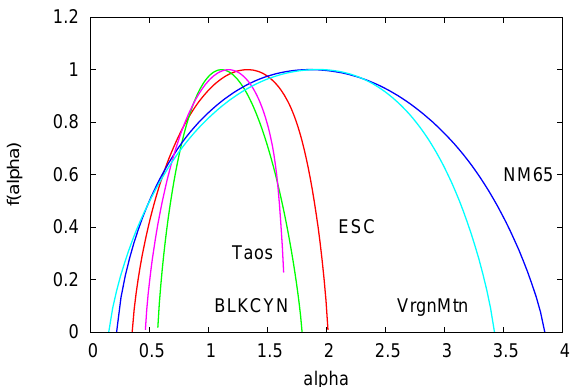
Fig. 7. Best-fitting model multifractal spectrum f ( α ) vs α for rock bodies of Precambrian age in southwest Colorado, western New Mexico, and northwest Arizona. ESC (red line) is in Escalante Canyon in the northeast central portion of the Uncompahgre uplift; BLKCYN (green line) is the Black Canyon of the Gunnison River, southwest Colorado; Taos (magenta line) is 4 sites north-northeast of Taos, New Mexico; NM65 (blue line) is west of Las Vegas, New Mexico, and VrgnMtn (turquoise line) is in the Virgin Mountains northeast of Mesquite, Nevada.